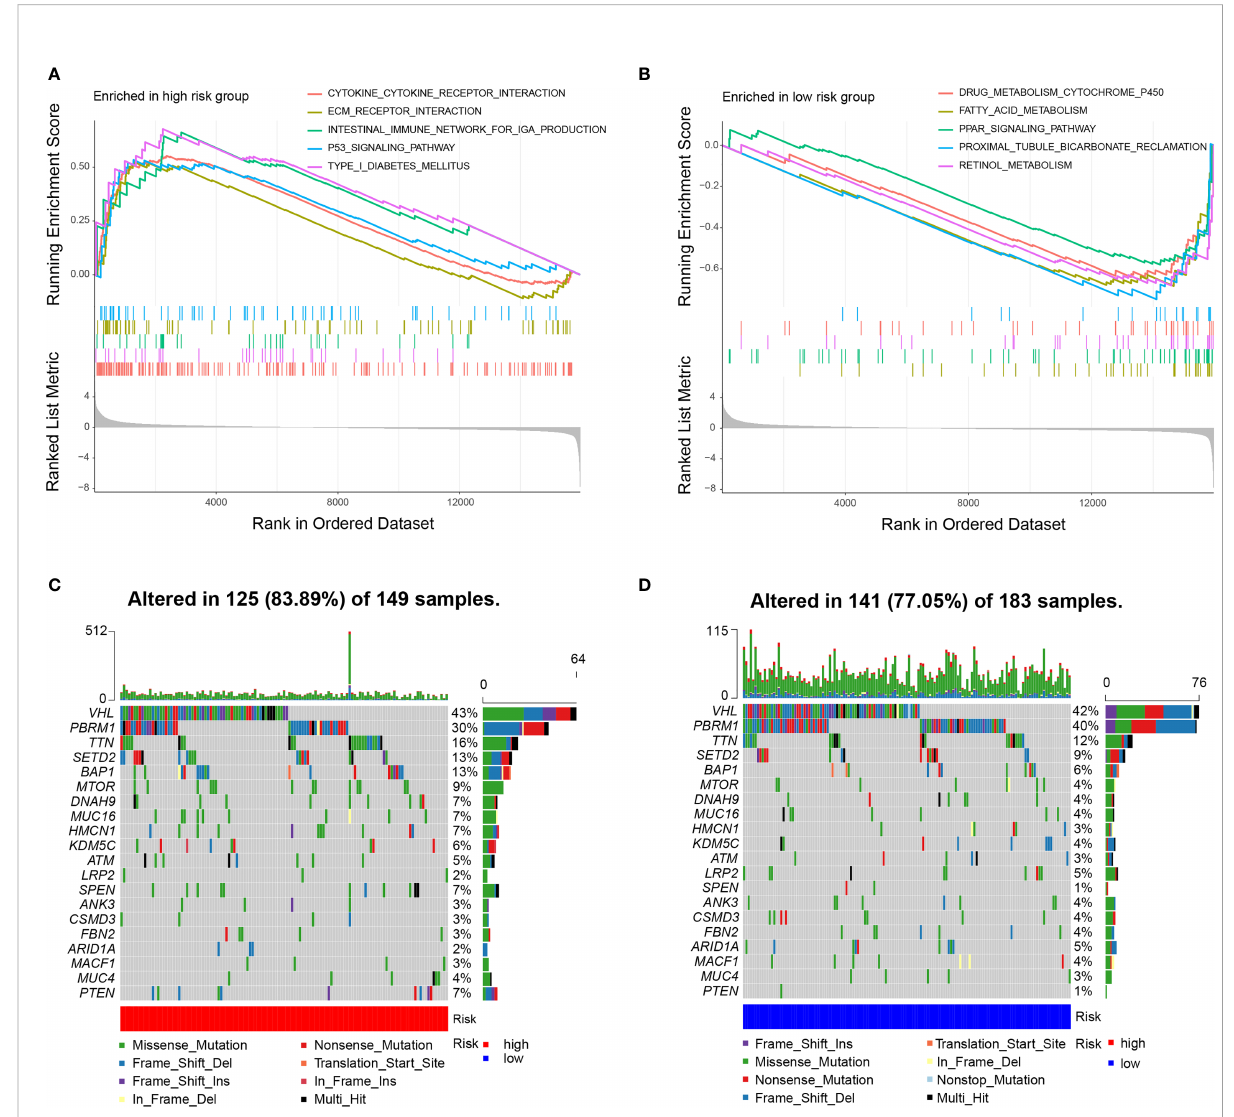
FIGURE 4 Molecular characteristics of subgroups. (A) Gene sets enriched in high-risk group (P < 0.05). (B) Gene sets enriched in low-risk group ( P < 0.05). (C, D) . Mutated genes in the mutated ccRCC samples of two subgroups. Top 20 mutated genes (rows) are ordered by mutation rate; samples (columns) are arranged to emphasize mutual exclusivity among